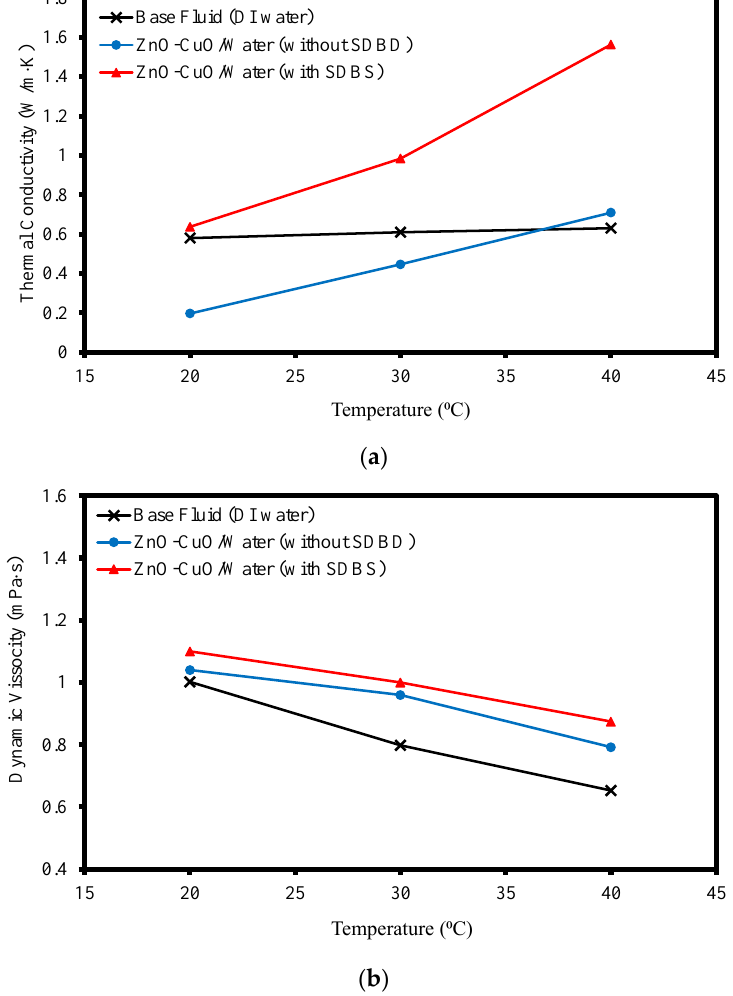
Figure 12. ( a ) Thermal conductivity and ( b ) viscosity of ZnO-CuO/water hybrid nanofluids at 5:5 ratio and DI water at temperature ranging 20 – 40 °C.